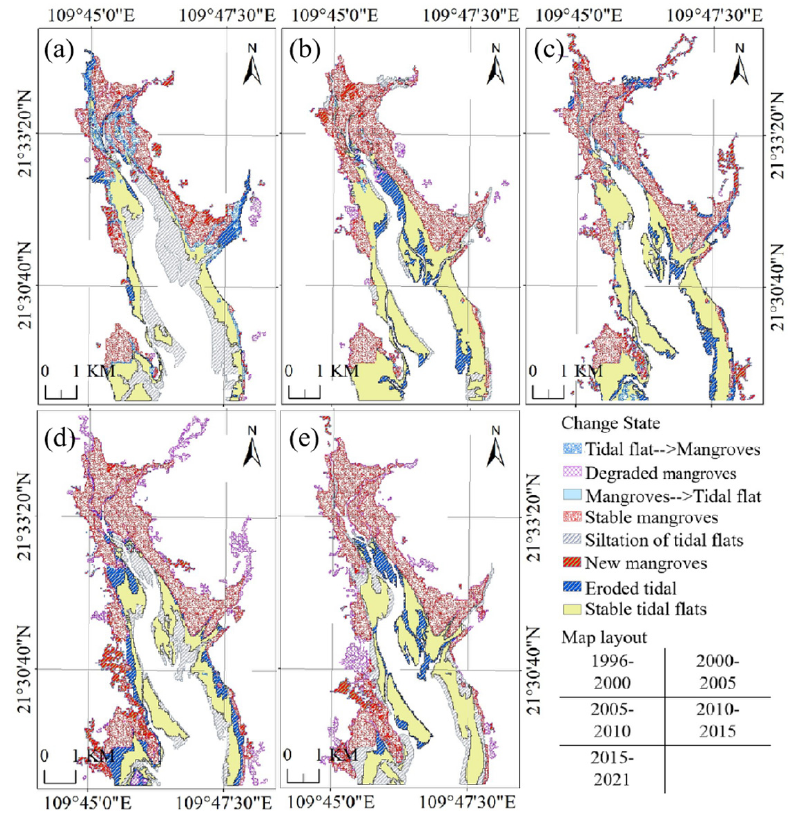
Figure 18. Tidal sequence change and centroid transfer of mangrove tidal flat in Shankou area. ( a ) Interclass changes of mangroves and tidal flats in Shankou area from 1996 to 2000. ( b ) Interclass changes of mangroves and tidal flats in Shankou area from 2000 to 2005. ( c ) Interclass changes of mangroves and tidal flats in Shankou area from 2005 to 2010. ( d ) Interclass changes of mangroves and tidal flats in Shankou area from 2010 to 2015. ( e ) Interclass changes of mangroves and tidal flats in Shankou area from 2015 to 2021.